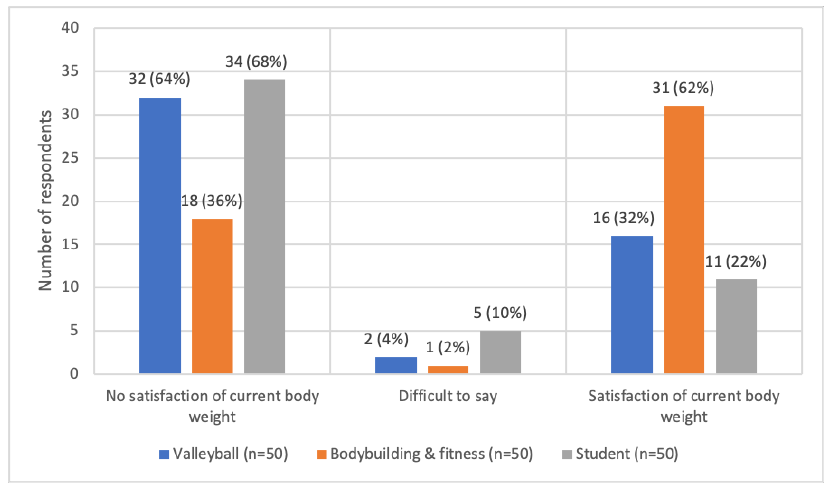
Figure 3. Satisfaction with their current body weight in the study groups.